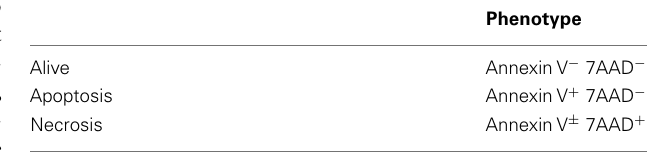
Table 2 | Identification of cell death